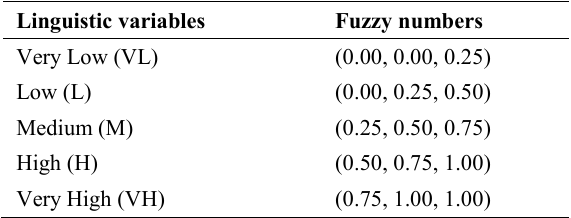
Table 3. Linguistic variables and fuzzy numbers Table 4. Aggregated fuzzy weights of the criteria